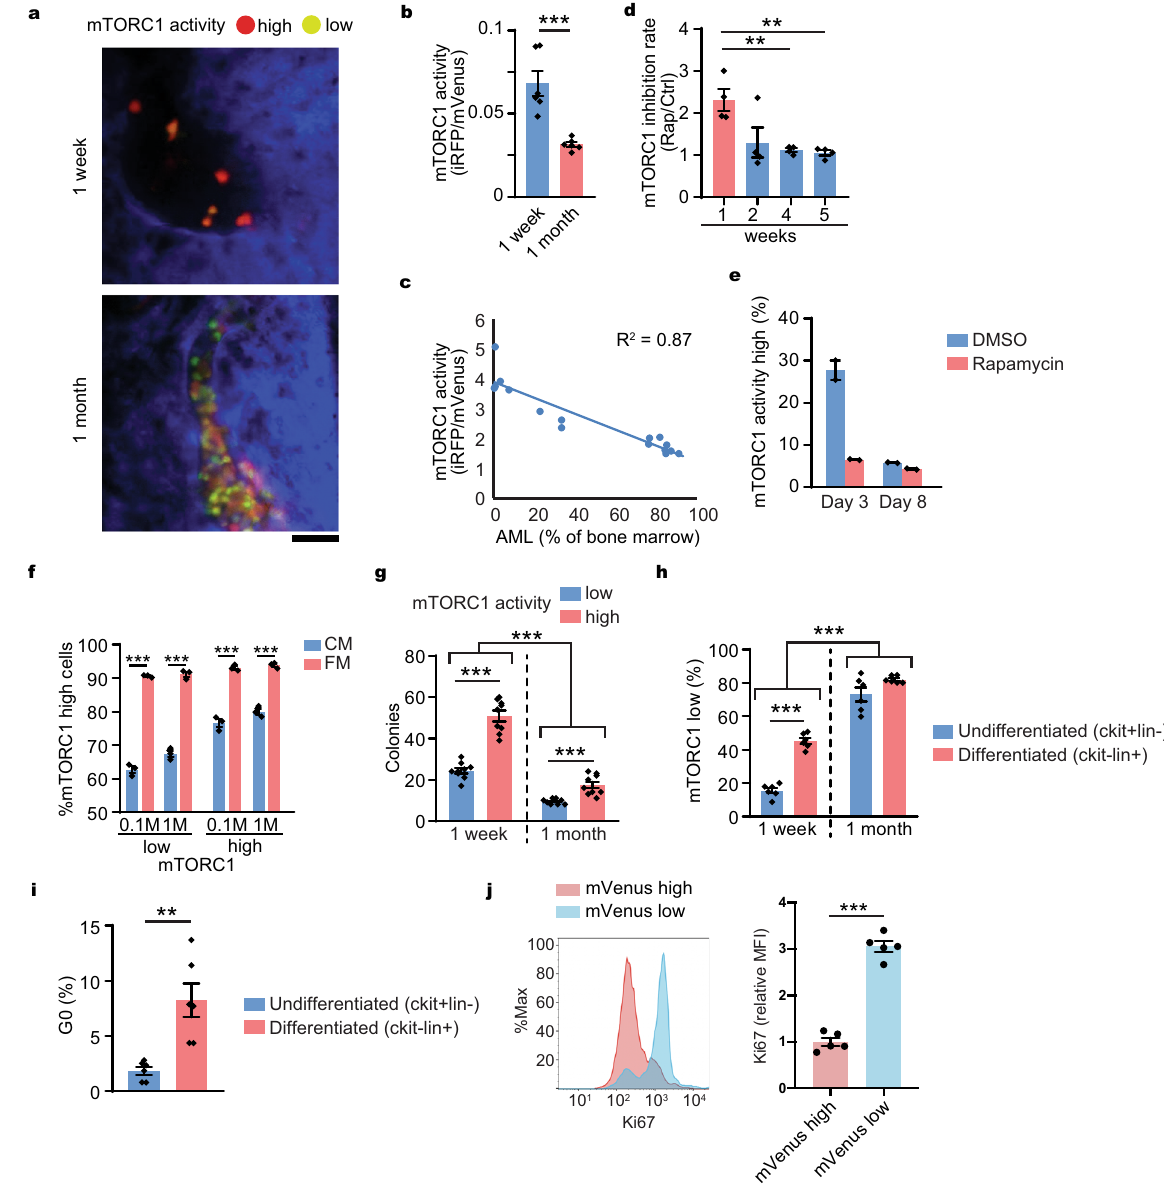
Fig. 2 mTORC1 activity is downregulated during AML progression. a Representative in vivo imaging of AML cell with mVenus-TOSI probe (FM4-Venus- TdT) in the mouse calvarial bone marrow from a similar visual fi eld of the same mouse using a confocal microscope during disease development at 1 week and 1 month after transplantation. Scale = 50 μ m. Red (mVenus − / TdTomato + ): mTORC1-high cells, Yellow-Green (mVenus + /TdTomato + ):